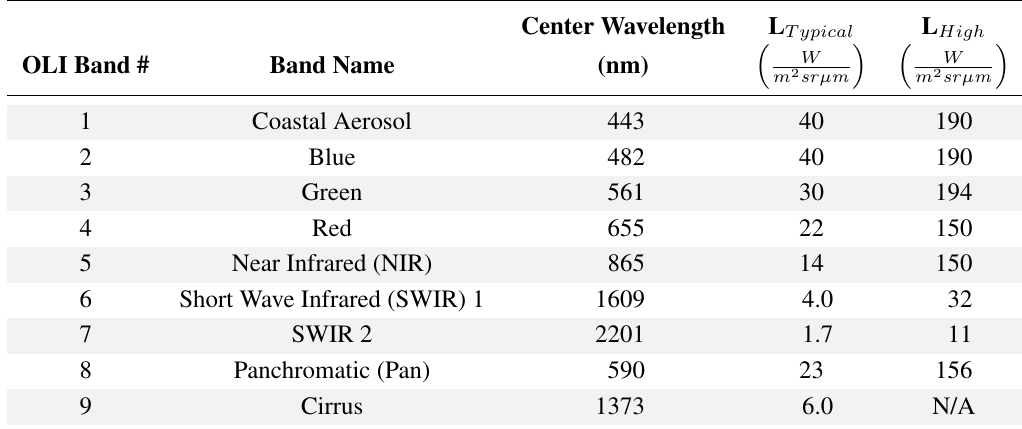
Table 1. Operational Land Imager spectral bands.